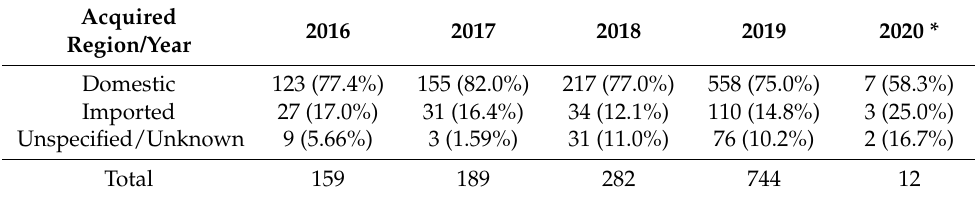
Table 3. Reported measles cases, aggregated by acquired regions [16,17,19].